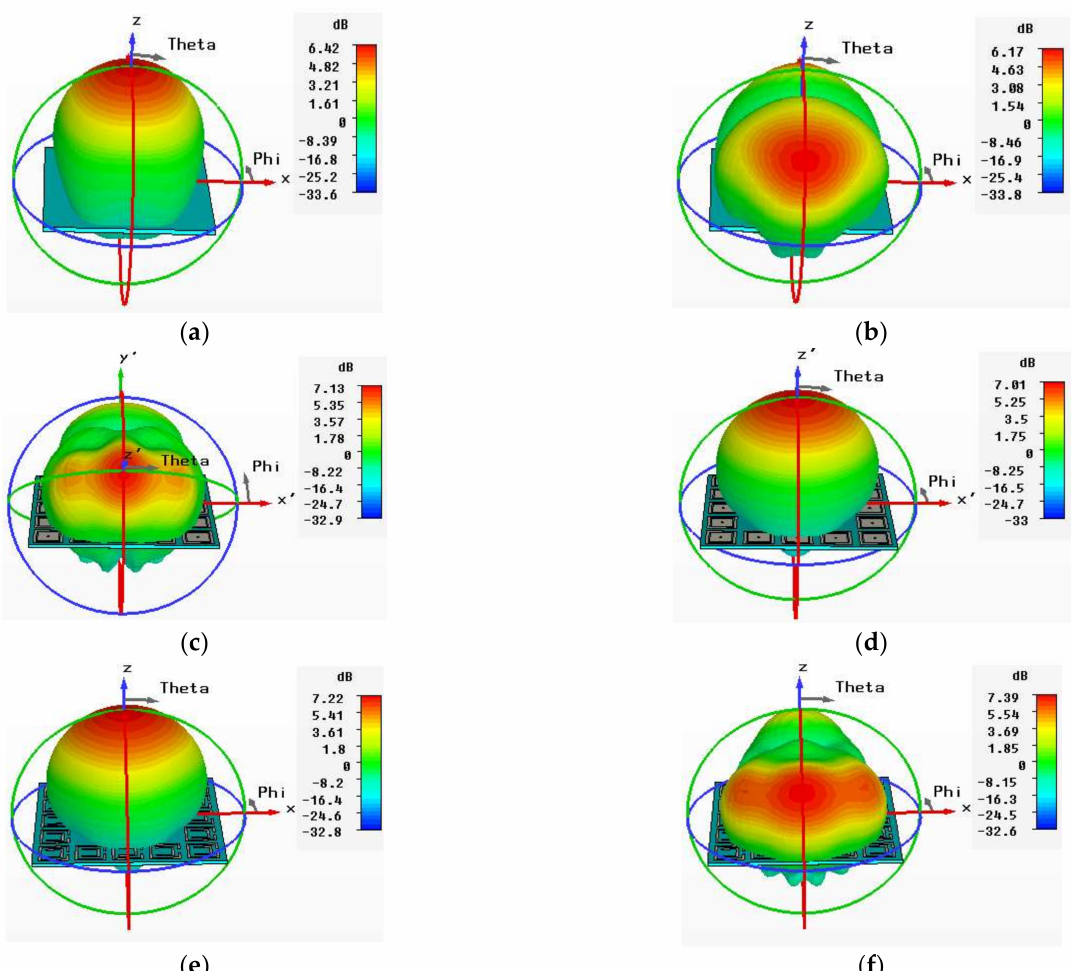
Figure 14. 3D radiation pattern of normal scenario. ( a ) Conventional antenna at 2.4 GHz. ( b ) Conven- tional antenna at 5.4 GHz. ( c ) EBG-based antenna at 2.4 GHz. ( d ) EBG-based antenna at 5.4 GHz. ( e ) SRR-based antenna at 2.4 GHz. ( f ) SRR-based antenna at 5.4